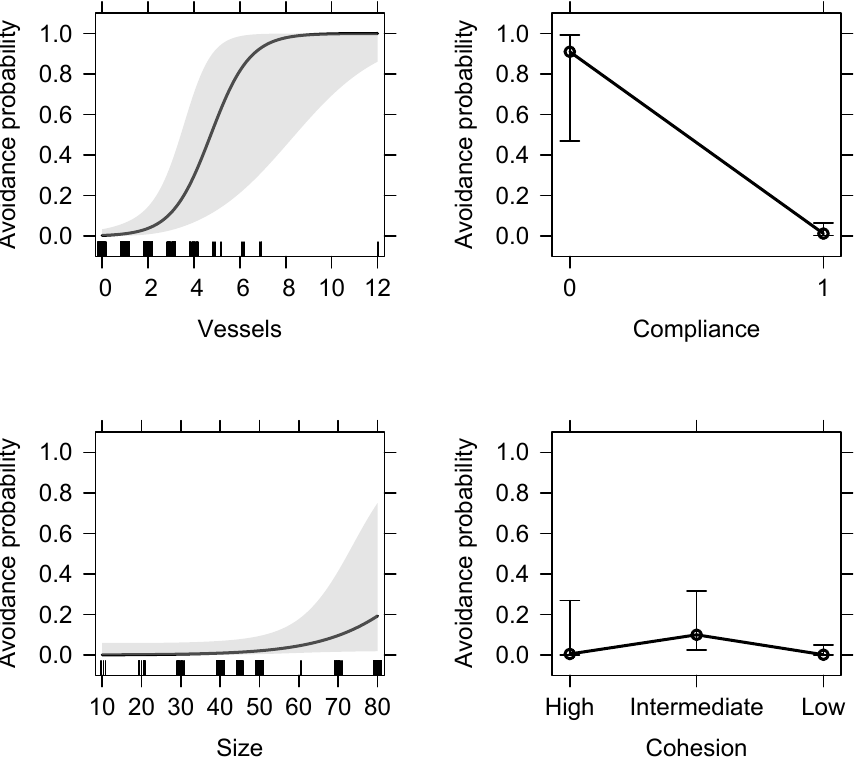
Figure 5. GLMM-predicted probabilities of avoidance of spinner dolphin groups in Reunion Island during vessel approaches, as predicted by the best generalised linear mixed-effects model, which included the number of vessels around the group (top left), non-compliance (=0) and compliance (=1) of vessels with the regulations (top right) and dolphin group size (bottom left) and cohesion (high, intermediate, low) (bottom right). The grey areas and error bars represent 95% confidence